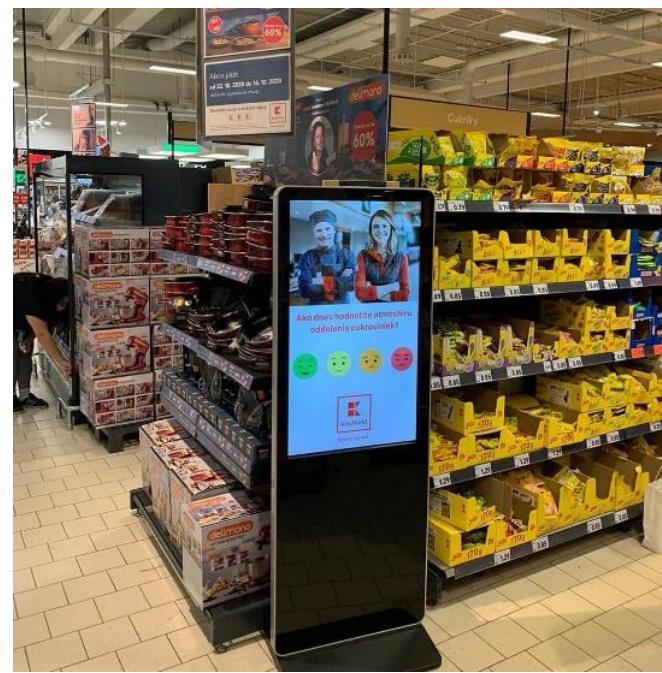
Figure 3. Special technology—smart aromatising kiosk.